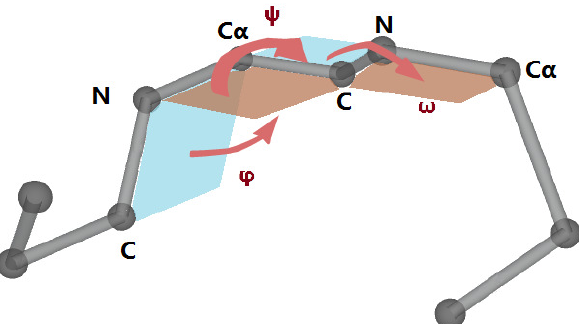
Figure 2. Examples of torsion angles φ , ψ , ω of the protein spatial structure. They represent the rotation angles of N atoms and C α atoms, C atoms and C α atoms, and C atoms and N atoms. Since the peptide plane is rigid, the absolute value of the ω angle is generally close to 180 ◦ (rarely 10 ◦ ) (Richardson